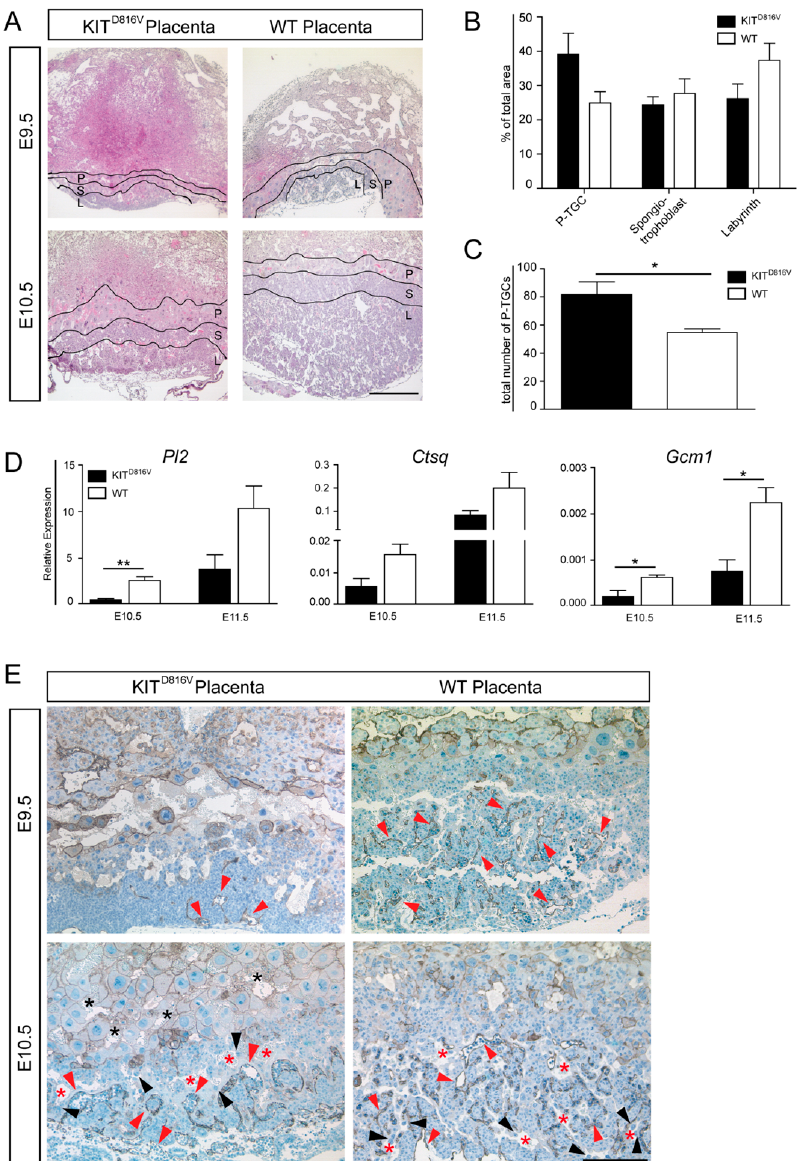
Figure 3. Placental structure is grossly a ff ected by KIT D816V . ( A ) Photomicrographs of hematoxylin and eosin (H&E) staining of para ffi n sections of KIT D816V and WT placentas on E9.5 (biological replicates = 2) and E10.5 (biological replicates = 3): Black lines mark areas of the P-TGCs (P), spongiotrophoblast (S), and labyrinth layer (L). Scale bar represents 500 μ m. ( B ) Quantification of P-TGC, spongiotrophoblast, and labyrinth areas at E10.5 compared to the total area of respective placenta (biological replicates = 3) and ( C ) quantification of number of P-TGCs in KIT D816V and WT placenta at E10.5 using ImageJ in three biological replicates: Significance was determined by unpaired t-test and indicated with * p < 0.05. ( D ) qRT-PCR analysis of labyrinth-specific TGC marker Pl2 , Ctsq , and Gcm in KIT D816V and WT placentas at E10.5 and E11.5. RNA was obtained from at least three biological replicates. Expression is normalized to the housekeeping gene Gapdh . Bars display mean value ± SD. Significance was determined by unpaired t-test and indicated with * p < 0.05 and ** p < 0.01; ( E ) Immunohistochemical staining of CD31 on paraffin sections of KIT D816V and WT placentas at E9.5 (biological replicates = 2) and E10.5 (biological replicates = 2): Red arrowheads indicate fetal endothelial cells enclosing fetal blood spaces, and black arrowheads indicate S-TGCs. Maternal sinusoids are indicated by red asterisks, and maternal blood in the P-TGC layer is indicated by black asterisks. Scale bar represents 200 μ m.